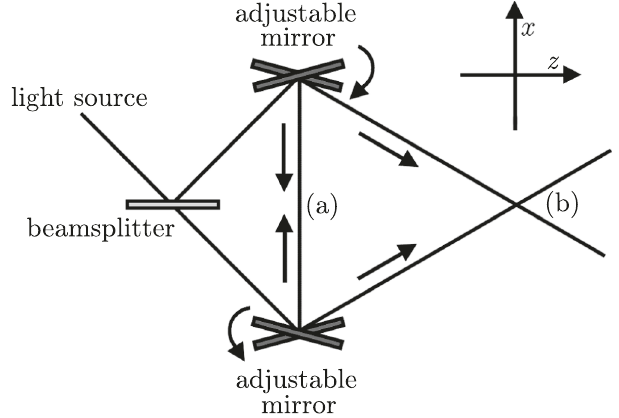
Fig. 1 Schematic diagram illustrating the geometry of the setup. The adjustable mirrors control the path of the photon in the transverse direction, which can be tuned to produce a head-on collision ( a ) or a grazing collision ( b